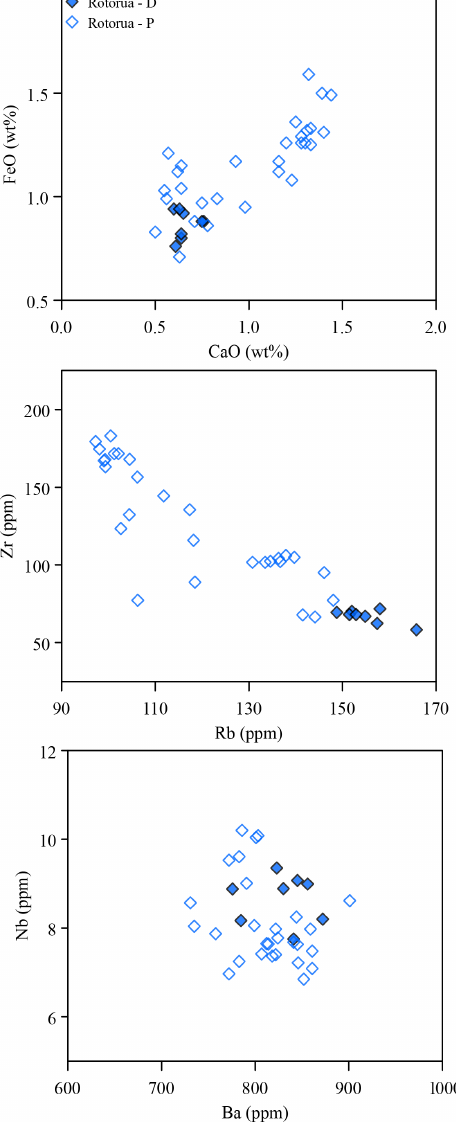
Figure 7. Major- and trace-element biplots showing the glass- shard-derived geochemical relationship of Rotorua (OVC) proxi- mal (P) and distal (D) tephra deposits (presented on a normalised basis, total iron expressed as FeO). Distal deposits may have a sig- nature with lower geochemical variability which overlaps within the spread of the heterogeneous proximal signatures. This variation can often be resolved by using trace-element plots of selected elements – see text for